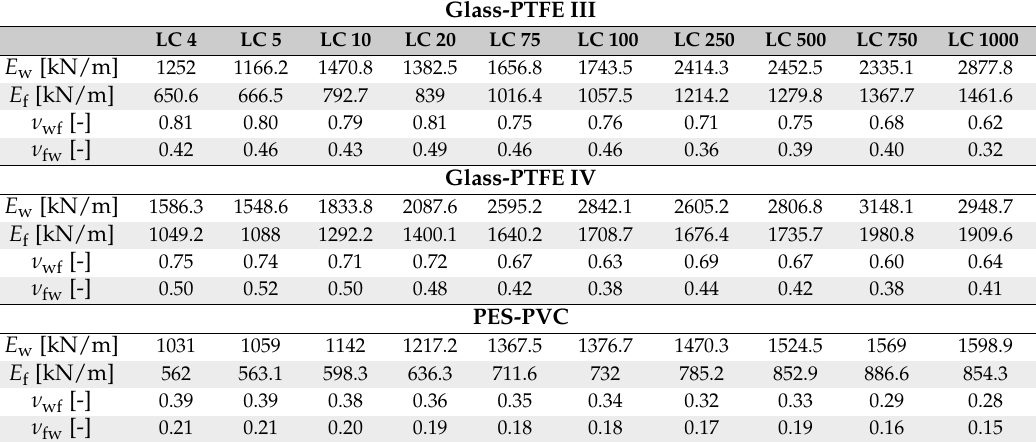
Table 5. Adjusted material parameter of the linear elastic